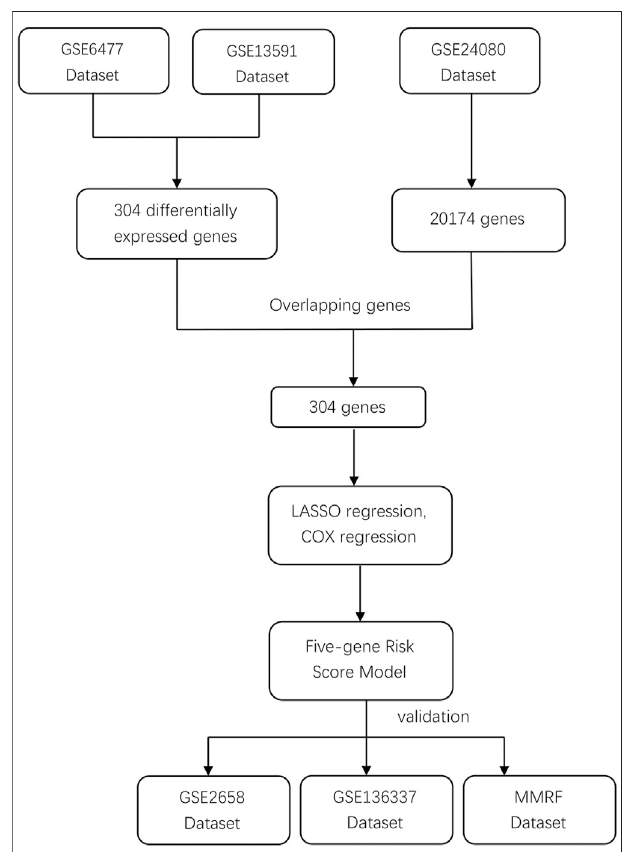
FIGURE1| Study fl owchartofprognostic modelbuildingand